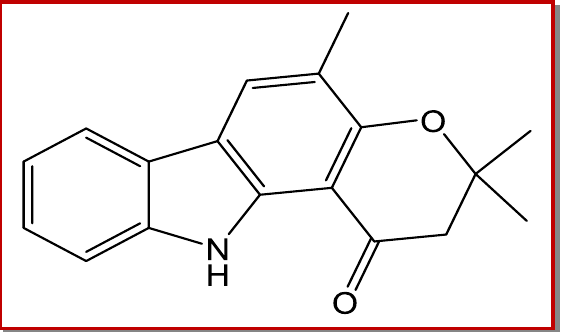
Figure 1: Chemical structure of euchrestifoline (Ecf)